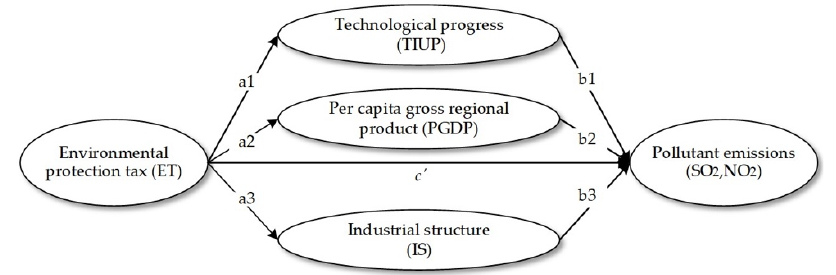
Figure 1. The mediation mechanism path of the environmental protection